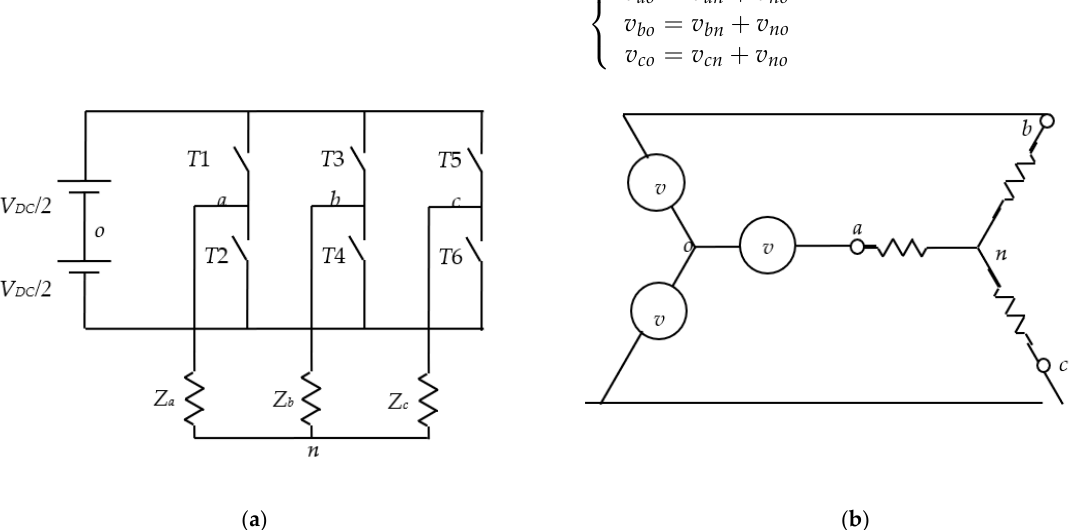
Figure 3. Three-phase inverter.( a ) Primary three-phase inverter, ( b ) circuit of the three-phase inverter.